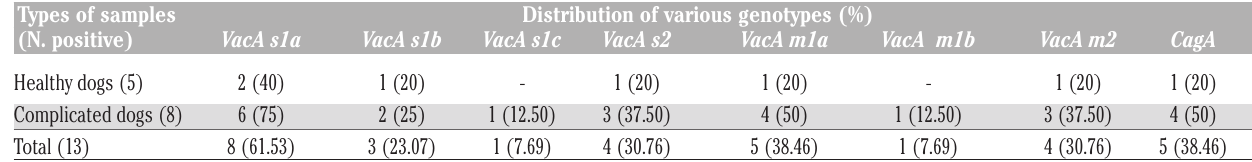
Table 3. Distribution of vacA and cagA genotypes among the Helicobacter pylori strains etected in fecal samples of dogs. Types of samples Distribution of various genotypes (%) (N. positive)